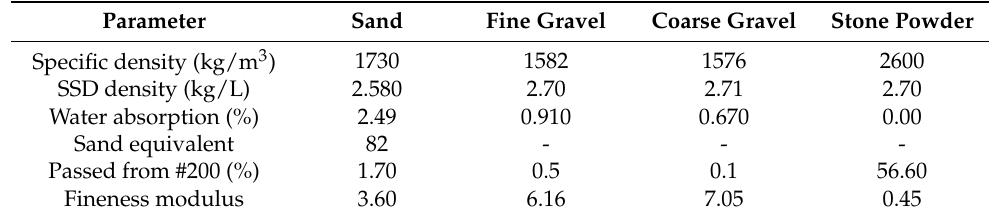
Table A2. Aggregates’